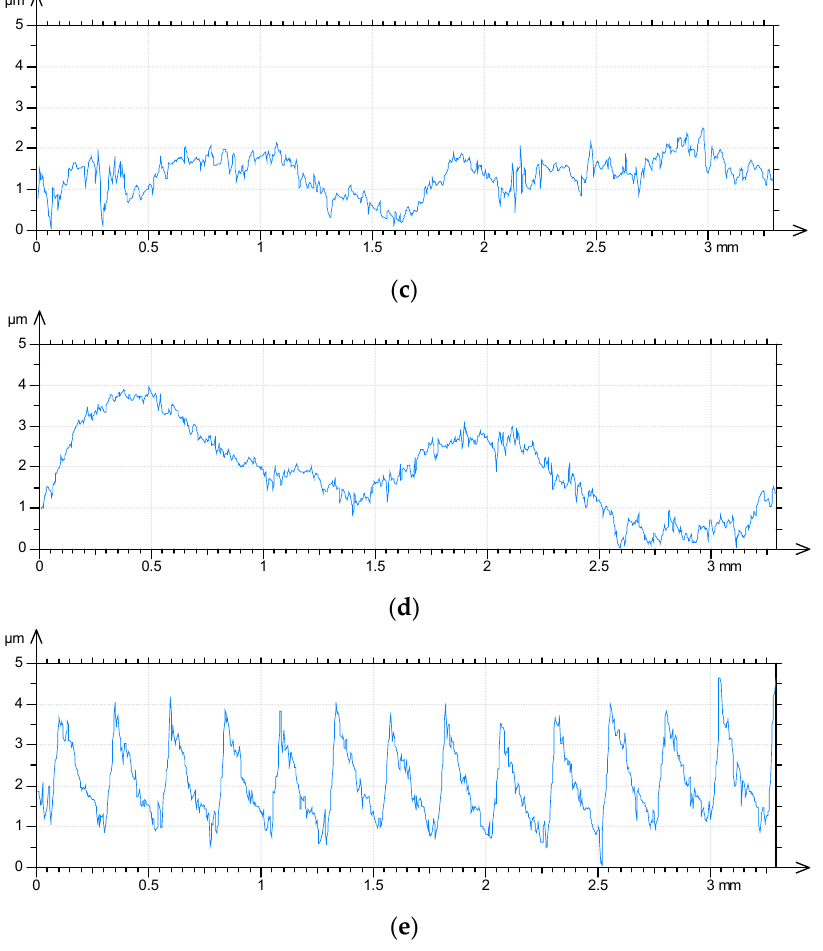
Figure 5. Representative profiles of burnished disc surfaces when pressure (P) was 10 MPa ( a ), 20 MPa ( b ), 30 MPa ( c ), 40 MPa ( d ) and of a milled disc surface ( e ).